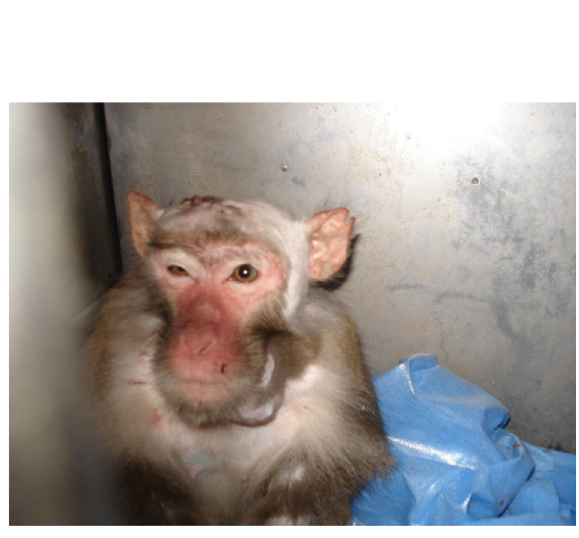
Figure 7. Experimental monkeys were successfully